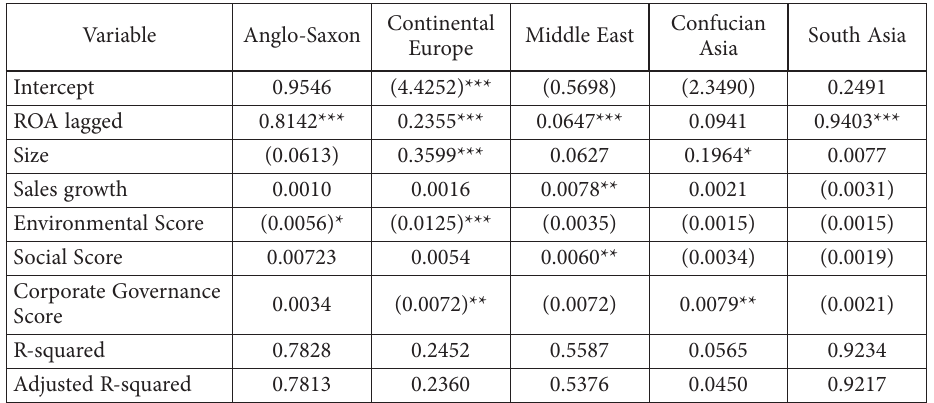
Table 5. Regression results for ROA – cultural